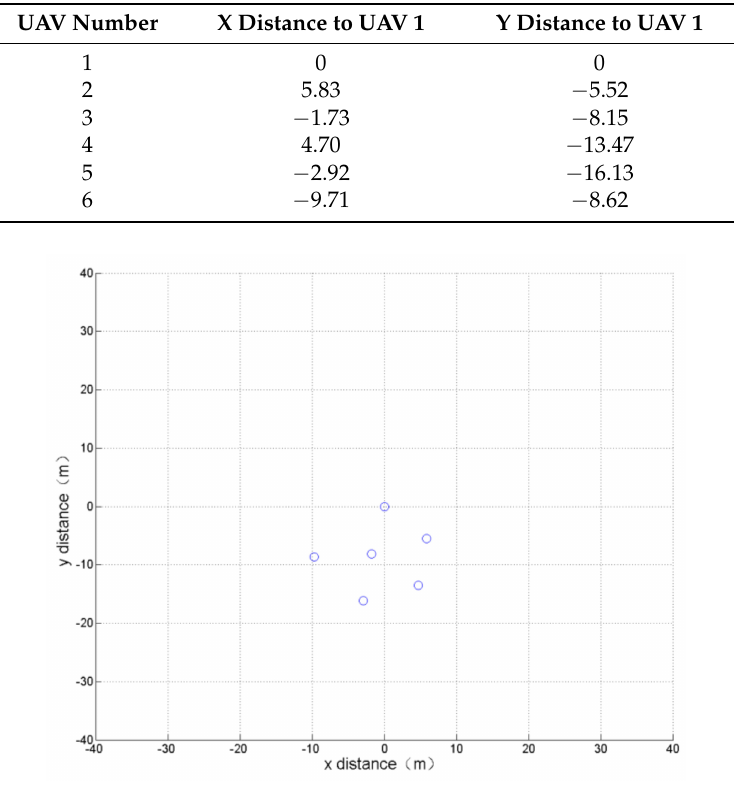
Figure 9. Formation optimization results of minimum average